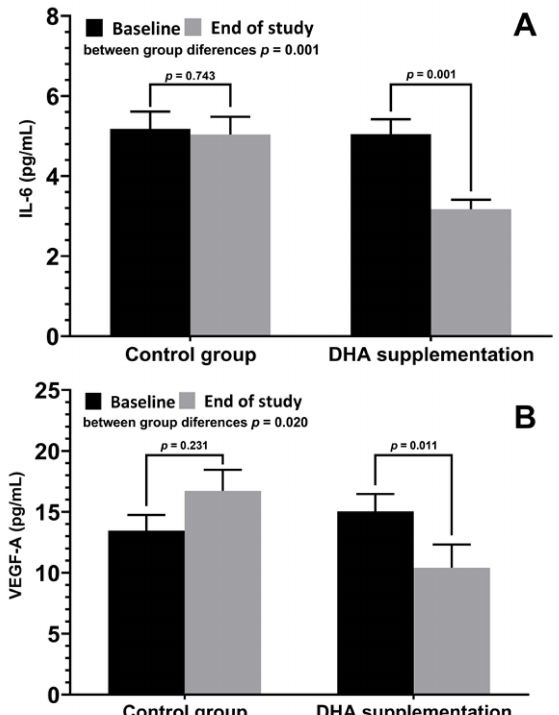
Figure 2. ( A ) Changes of plasma levels of IL-6 (mean ± SD) at baseline and at the end of the study in patients treated with DHA supplementation and controls, with significant decreases in the DHA group ( p = 0.001) and significant between-group differences ( p = 0.001). ( B ) Changes of VEGF-A (mean ± SD), with a significant decrease in the DHA group ( p = 0.011) and with significant between- group differences ( p =